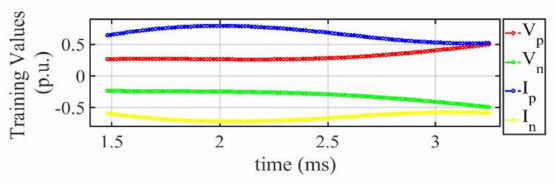
Figure 29. Training values for the SVM algorithm.